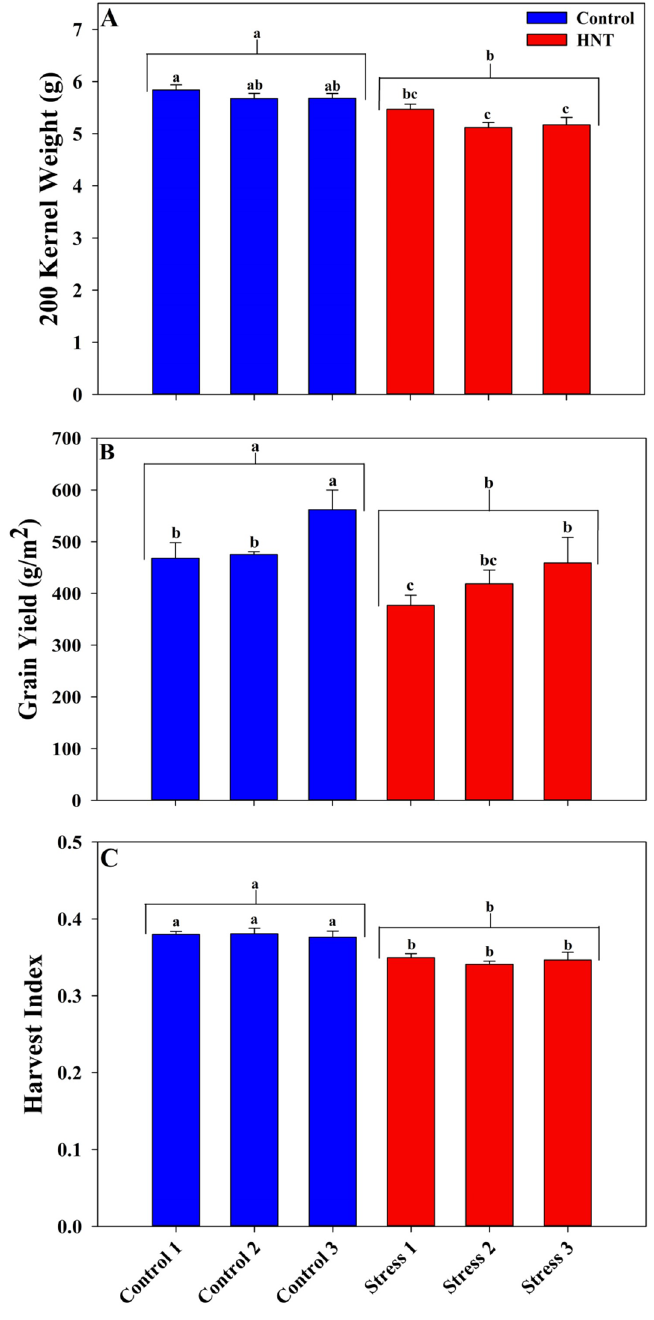
Figure 4. Comparison of Everest check lines planted randomly in each of the eight blocks within a tent. Comparison of 200 Kernel Weight (g) ( A ), grain yield (g/m 2 ) ( B ) and Harvest index ( C ) in the three control and stress tents. Each column is an average of eight rows of check line Everest and bars indicate ± SE. Letters above the bars indicate groups differing significantly between individual stress repetitions and the letters above the brackets indicate groups differing significantly between overall average between control and stress groups (p <